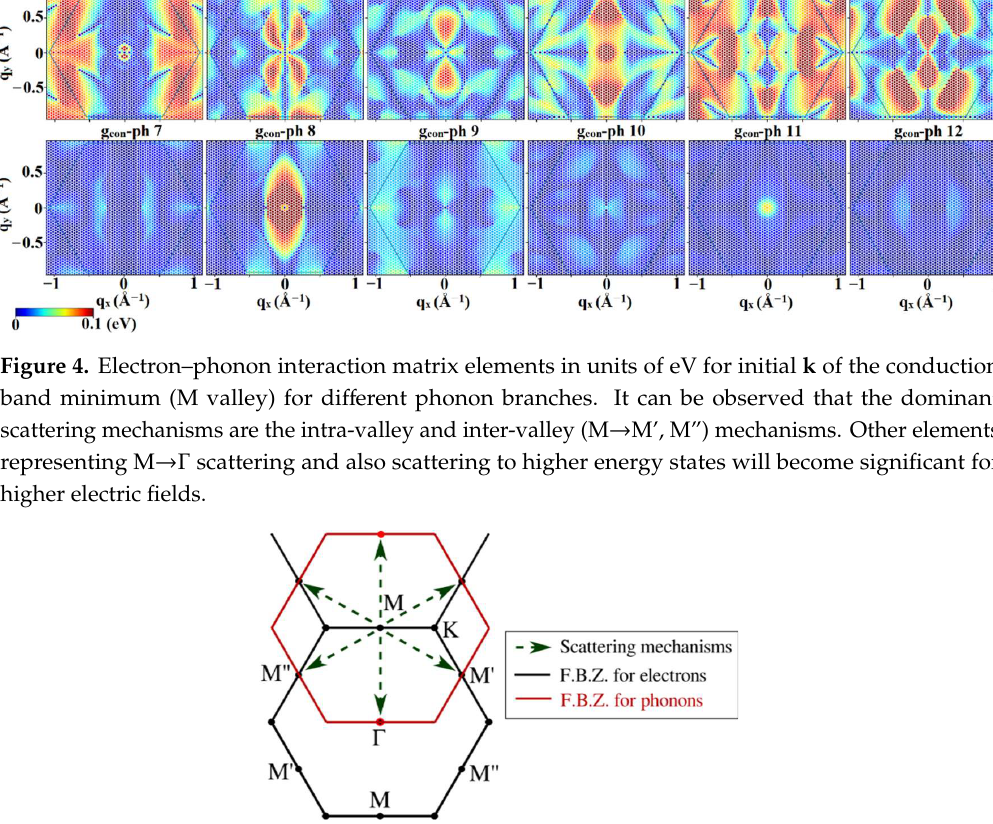
Figure 5. Schematic of possible inter-valley scattering mechanisms for electrons placed at conduction band minimum (M point).